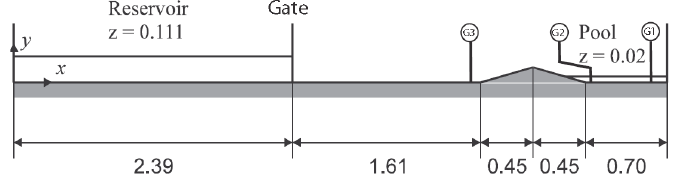
Figure 5. Geometrical properties of experimental model [40].